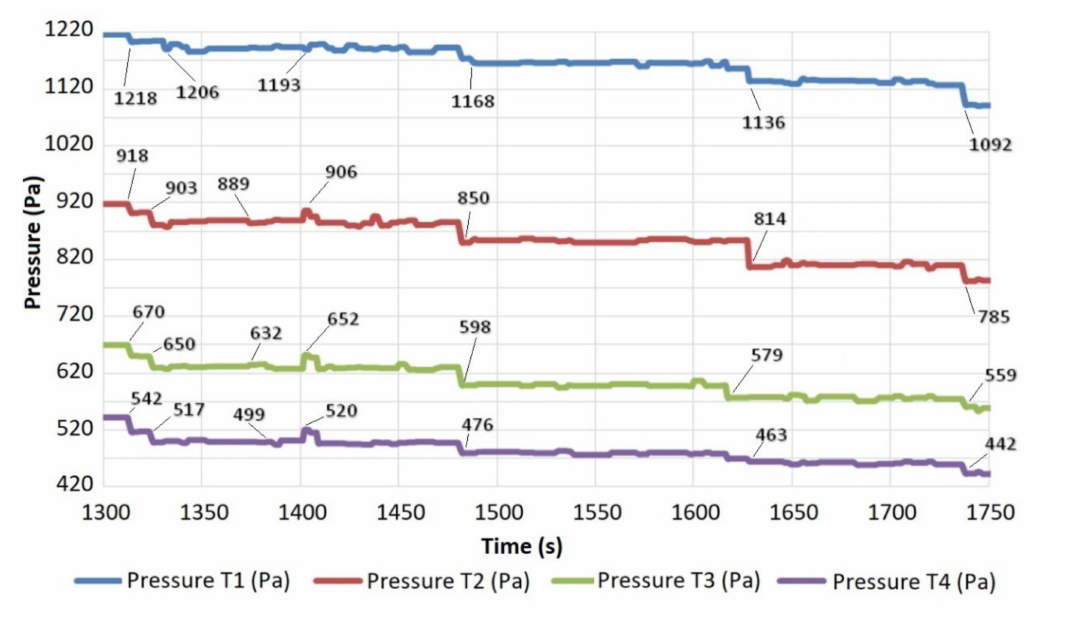
Figure 12. Gradual unsealing of the ventube.